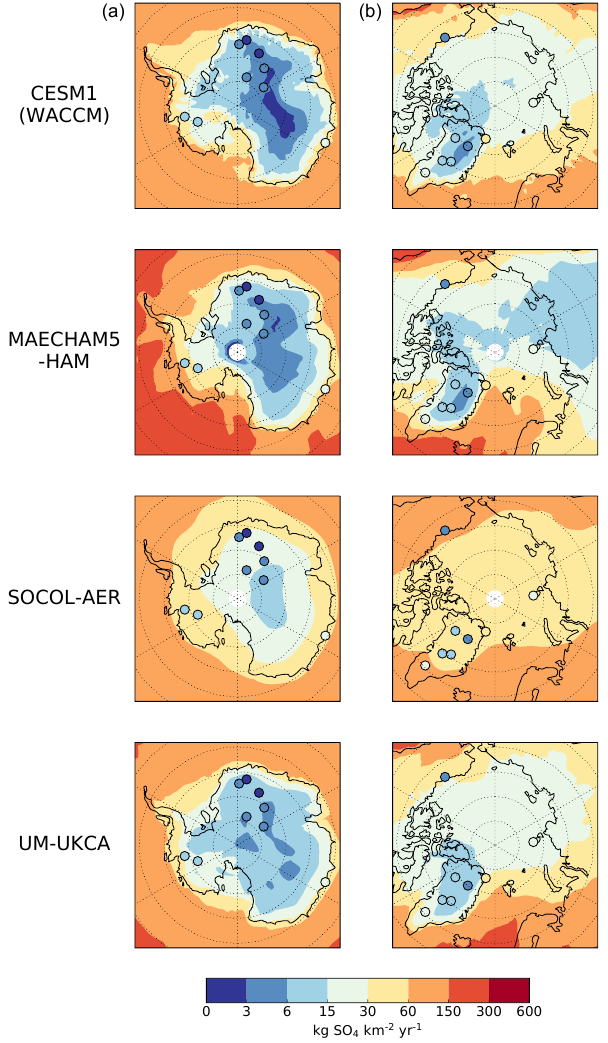
Figure 2. Total (wet + dry) sulfate deposition fluxes (kgSO 4 km − 2 yr − 1 ) for Antarctica (a) and the Arctic (b) for the preindustrial background from the control simulations (shad- ing) compared to preindustrial ice core sulfate fluxes (filled circles), averaged for 1850 to